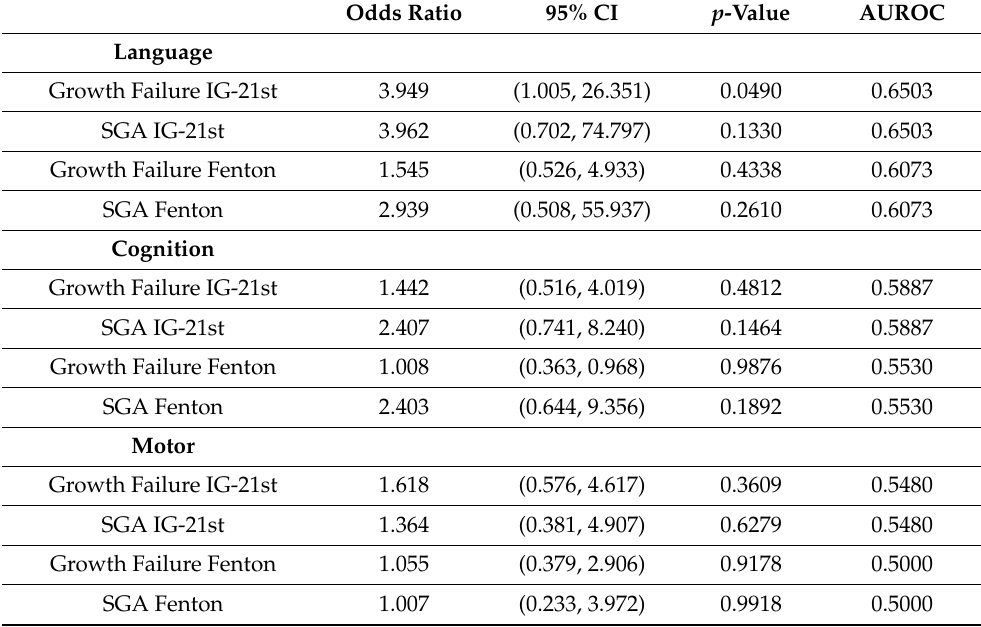
Table 5. SGA(small for gestational age)-adjusted analyses of weight-based growth failure as predictor of adverse neurodevelopmental